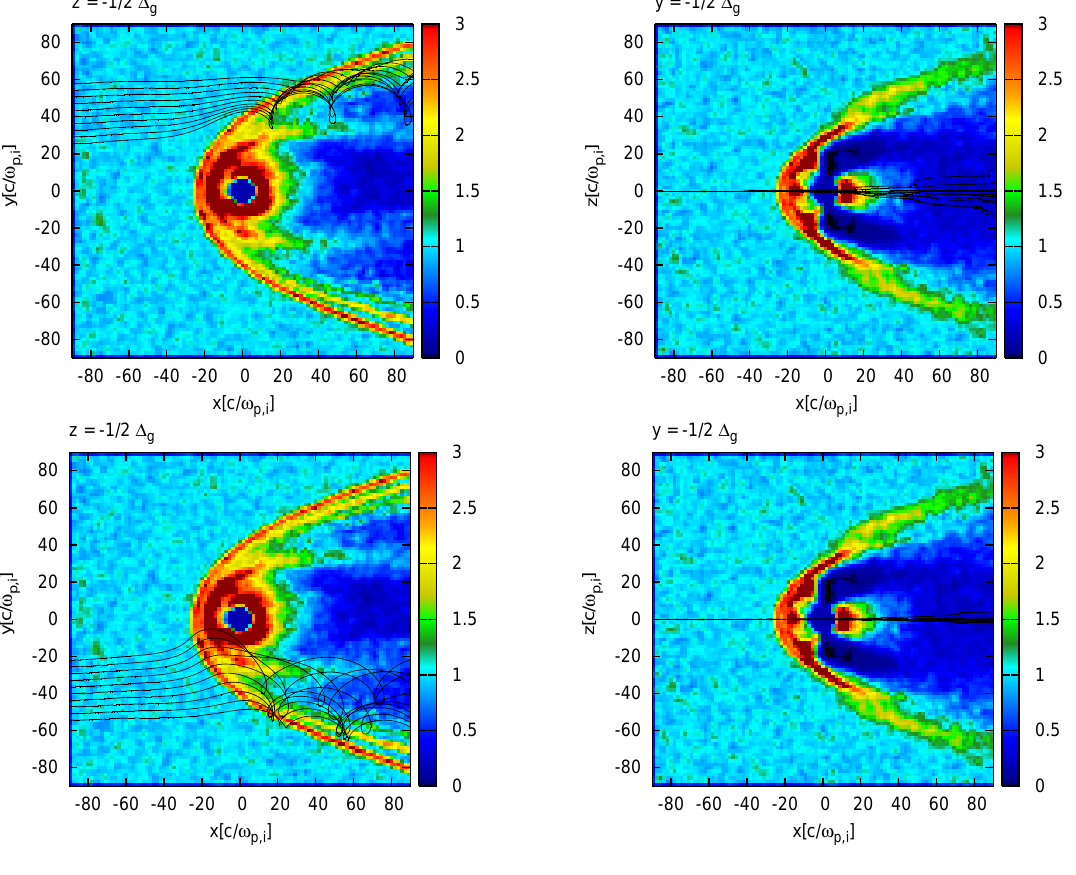
Fig. 5. Substructure of the boundary layer ( M ↑↓ B SW ) – Particle trajectories, starting from the intersection line of the (x,y) plane and the left face of the simulation domain. The figure shows the projections of the particle trajectories on the planes z =− 1 g / 2 and y =− 1 g / 2 as well as the normalized plasma density n/n 0 in these planes for the quasi-stationary state of the simulation. It is important to know that both figures display the same particle trajectories, starting with z = 0 at the left hand boundary of the simulation domain. It is illustrated that the scales of the interaction region are comparable to the characteristic length scales of ion motion. It is obvious that the substructure of the boundary layer – several sharp curves denoting an increase of plasma density – emerges from the finite gyroradius of individual solar wind